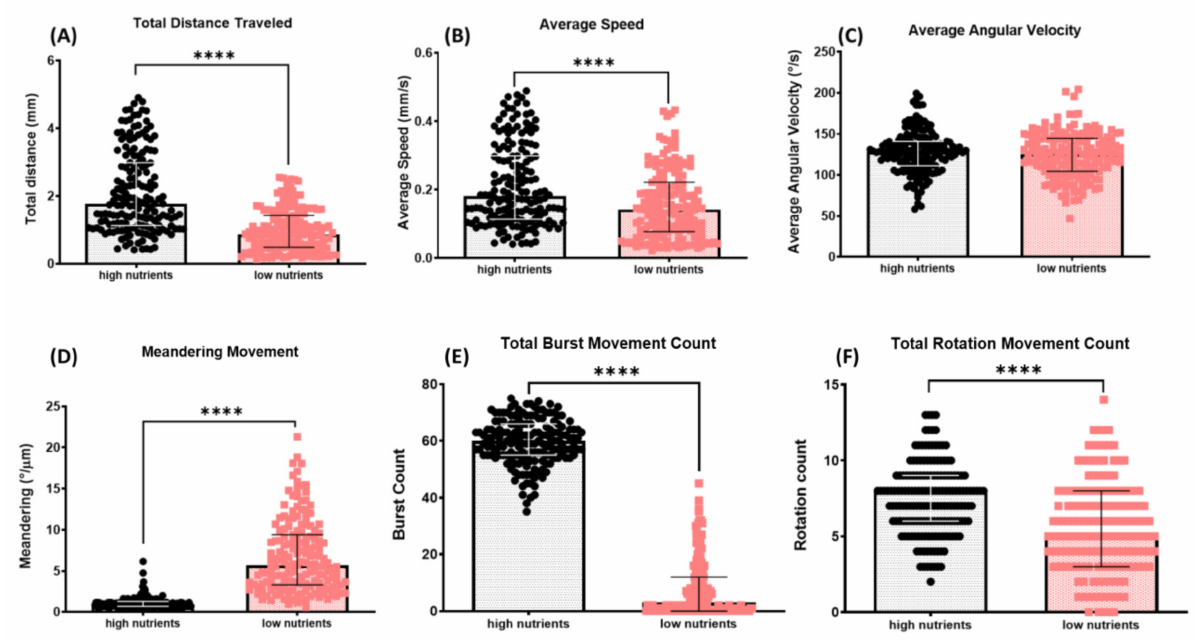
Figure 4. Comparison of T. thermophila locomotor activity in high- and low-nutrient media for 10 s. Six locomotor endpoints of ( A ) total distance traveled, ( B ) average speed, ( C ) average angular velocity, ( D ) meandering movement, ( E ) burst movement, and ( F ) rotation movement were statistically analyzed by Mann–Whitney test ( n = 167 for each group; **** p value < 0.0001). Median and interquartile range are used to express the data. Cumulative trajectory paths are presented in Figure